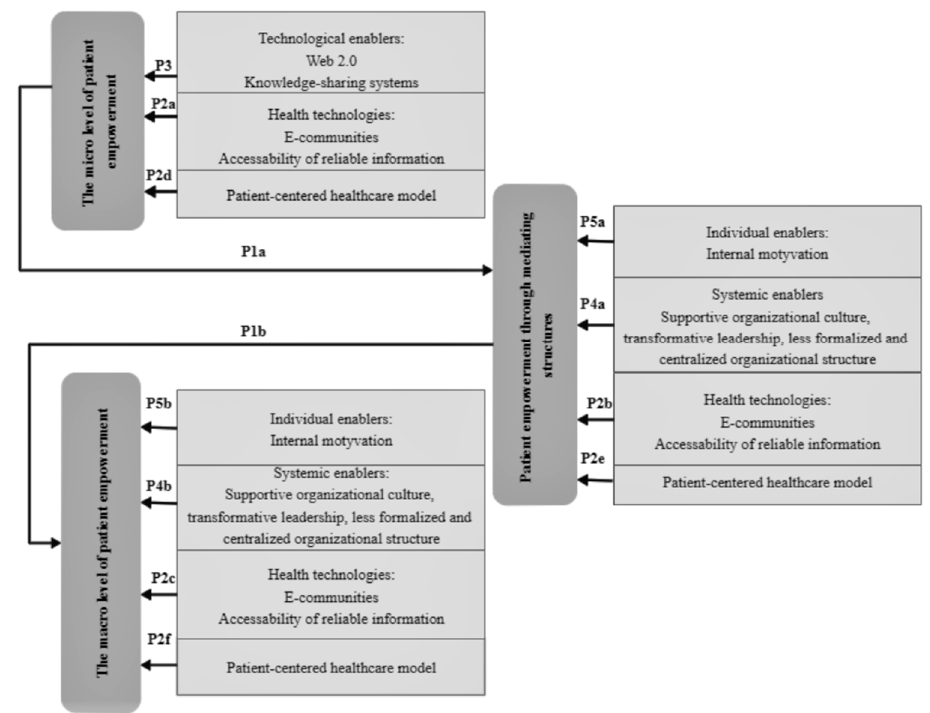
Figure 2. Enablers of patient knowledge empowerment for self-management of chronic disease framework. Note: P1a and P1b relationships are grounded by Proposition 1; P2a, P2b, P2c, P2d, P2e, and P2f relationships are grounded by Proposition 2; P3 relationship is grounded by Proposition 3; P4a and P4b relationships grounded by Proposition 4; and P5a and P5b relationships grounded by Proposition 5.